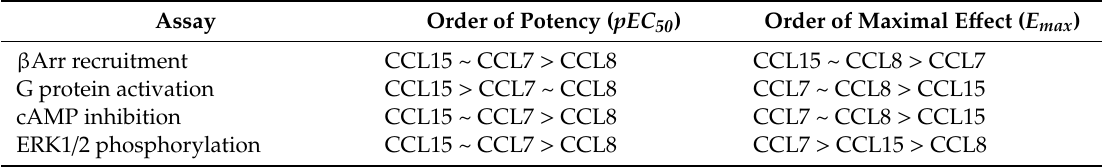
Table 2. Rank orders of potency and maximal e ff ect for CCR1 activation by chemokines 1 . Assay Order of Potency ( pEC 50 ) Order of Maximal E ff ect ( E max ) β Arr recruitment CCL15 ~ CCL7 > CCL8 CCL15 ~ CCL8 > CCL7 G protein activation CCL15 > CCL7 ~ CCL8 CCL7 ~ CCL8 >